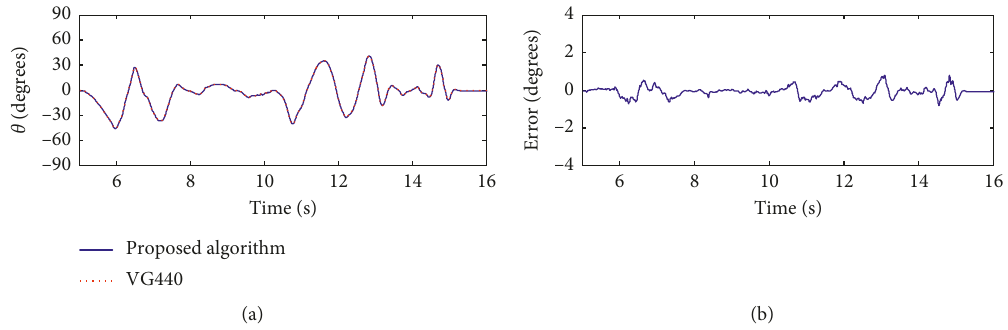
Figure 5: Pitch angle: (a) comparison of the measured values; (b) errors.